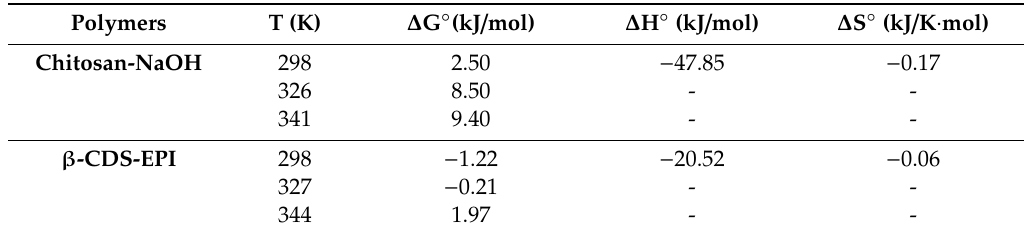
Table 4. Thermodynamic parameters for the adsorption of Direct Blue 78 onto chitosan-NaOH and β -CDs-EPI polymers at di ff erent